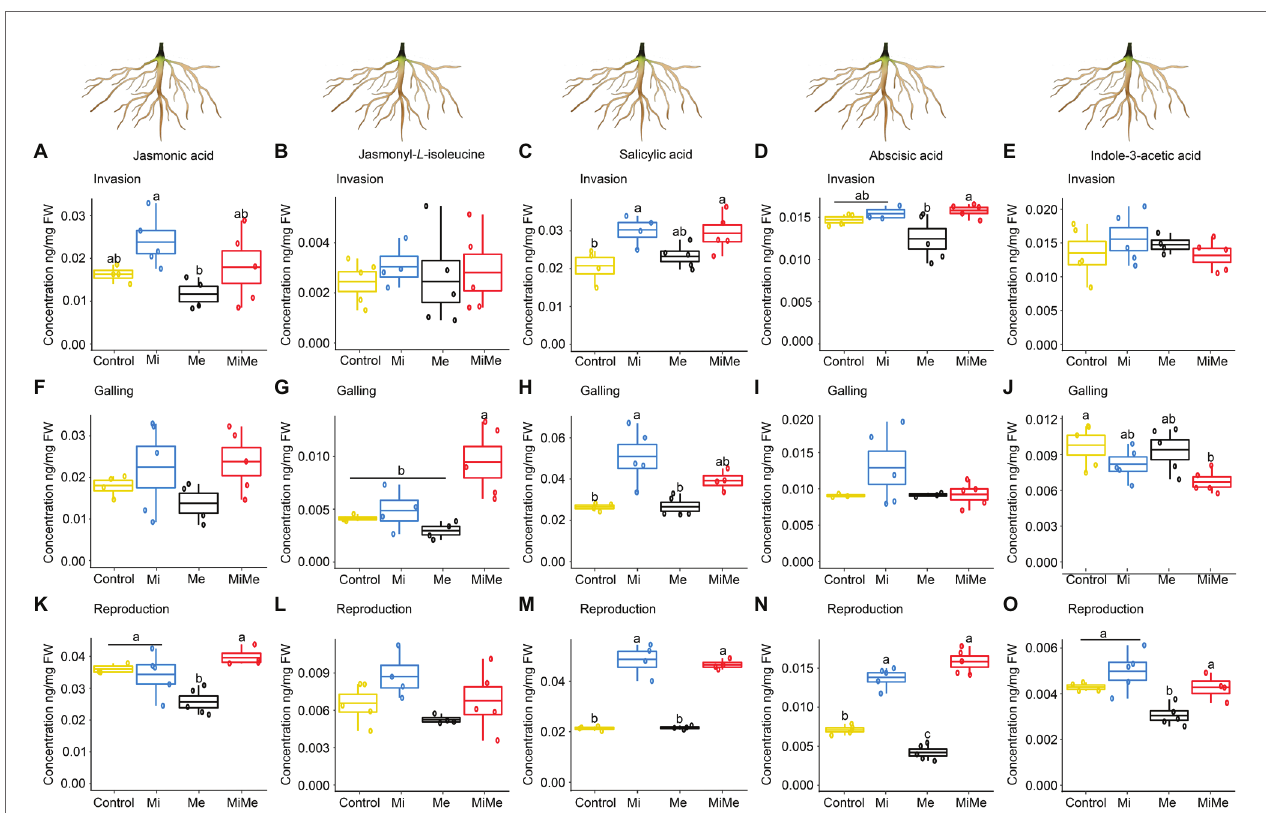
FIGURE 4 | Phytohormones concentrations in tomato roots upon aboveground and belowground herbivory. Mean concentrations (ng/mg fresh weight) of phytohormones in roots of tomato infected belowground with Meloidogyne incognita (Mi), or infested aboveground with Macrosiphum euphorbiae (Me) or with both herbivores (MiMe). Control = plants without herbivores. Boxplots indicate the mean (±SEM, n = 5) of JA (A,F,K) , jasmonyl- L -isoleucine (B,G,L) , SA (C,H,M) ; abscisic acid (D,I,N) and indole-3-acetic acid (E,J,O) concentrations measured at the nematodes’ invasion (A-E) , galling (F-J) , or reproduction (K-O) stages. Different letters above the boxplots indicate significant differences ( p ≤ 0.05) in mean values between treatments, determined by Tukey's HSD test after ANOVA